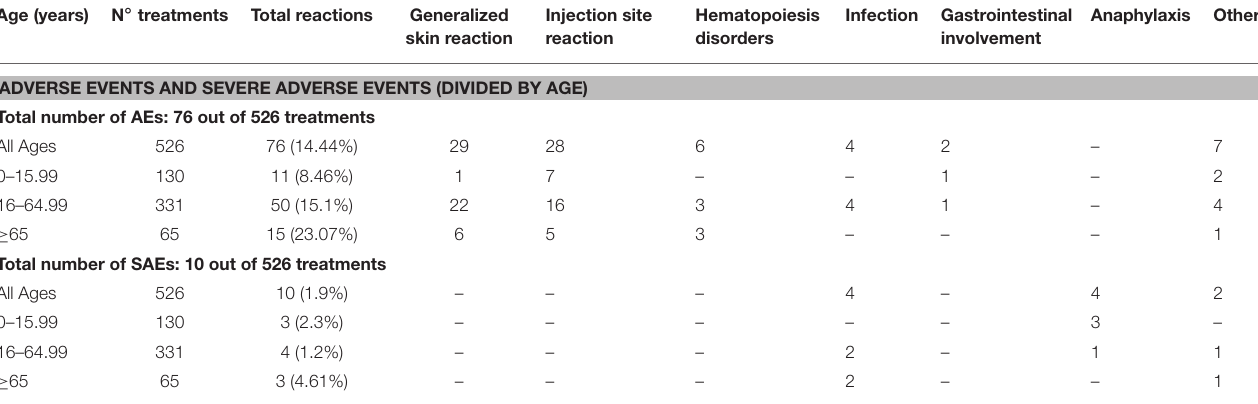
TABLE 7 | Frequency of different adverse events and severe adverse events according to the age of